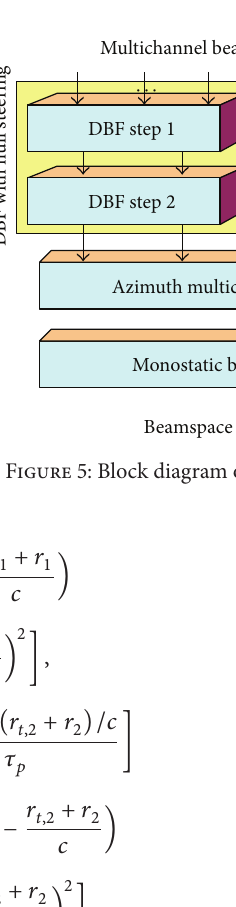
Figure 4: The block diagram of the real time conventional DBF processor in elevation onboard.